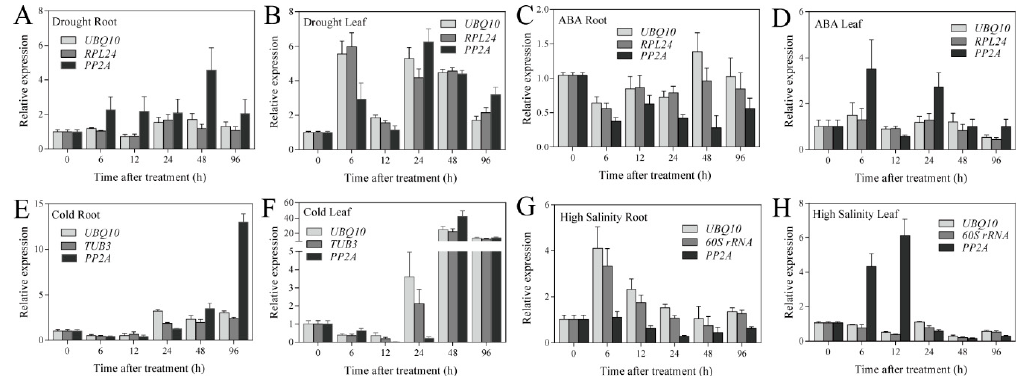
Figure 6. Relative expression levels of PuGI under different experimental conditions normalized by the top two stable genes and an unstable gene. ( A ),( B ) Drought stress; ( C ),( D ) ABA treatment; ( E ),( F ) cold stress; and ( G ),( H ) high salinity stress.